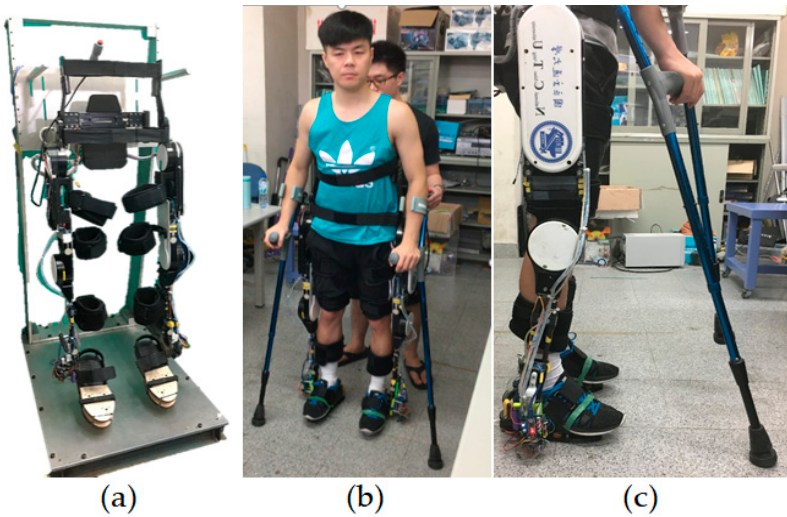
Figure 1. ( a ) Exoskeleton dangles on the rack; ( b ) the front view for a test subject wearing the exoskeleton and standing on the ground; and ( c ) side view for a test subject wearing the exoskeleton and standing on the ground.